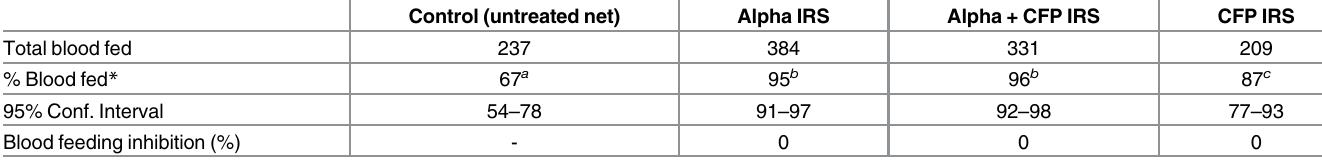
Table 3. Blood feeding rates of wild pyrethroid resistant An gambiae sl in experimental huts in Cove,